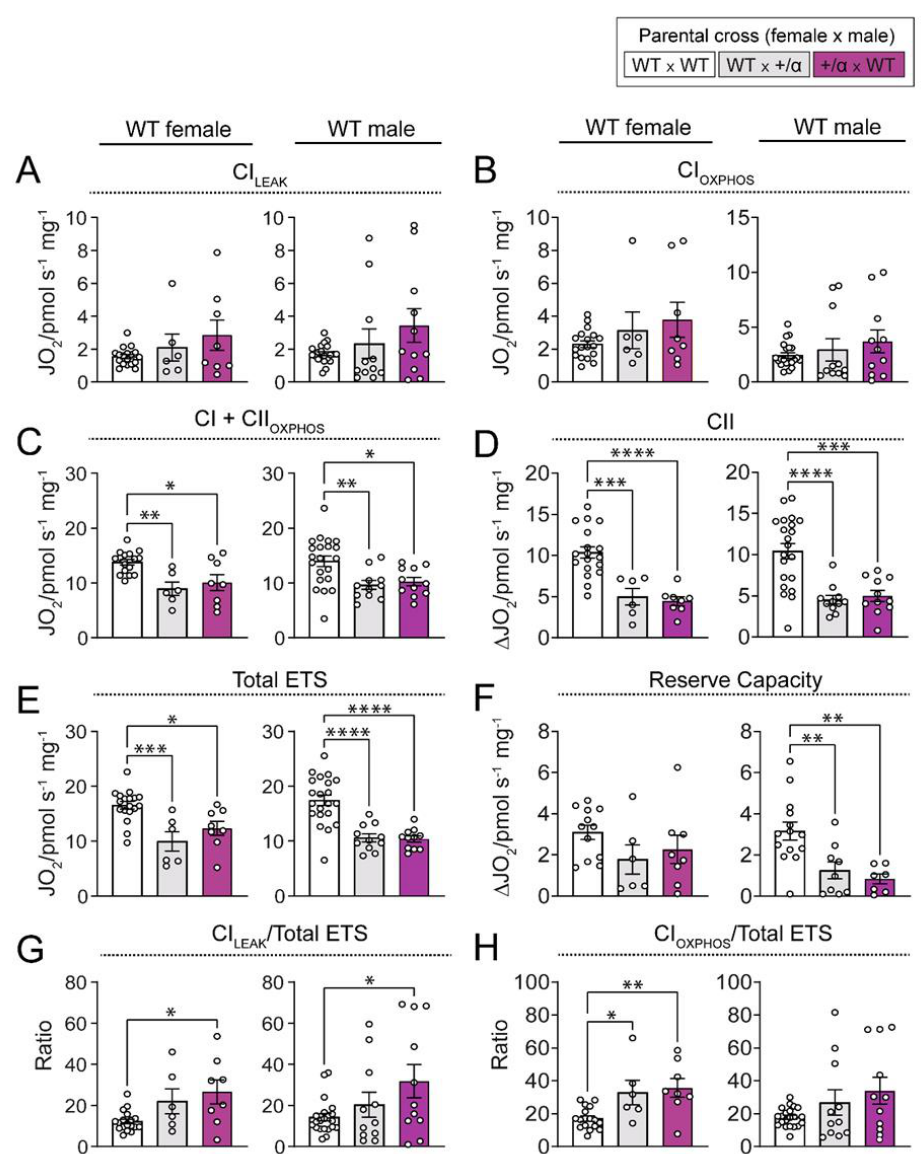
Figure 3. Placental mitochondrial bioenergetics of WT conceptuses in response to littermate and/or maternal p110 α deficiency. Oxygen consumption in the placental LZ associated with CI LEAK ( A ), CI OXPHOS ( B ), CI + CII OXPHOS ( C ), CII ( D ), total ETS ( E ), reserve capacity ( F ), CI LEAK /total ETS ( G ), and CI OXPHOS /total ETS ( H ) for females and males on day 18 of pregnancy. Data are from WT fetuses generated by WT x WT, WT x α /+, and α /+ x WT parental crosses ( n = 1–2 fetuses/sex/dam with 5–12 dams/group) and are displayed as individual data points with mean ± S.E.M. Data were analysed by one-way ANOVA with Tukey post hoc pairwise comparisons (* p < 0.05, ** p < 0.01, *** p < 0.001, **** p < 0.0001, pairwise